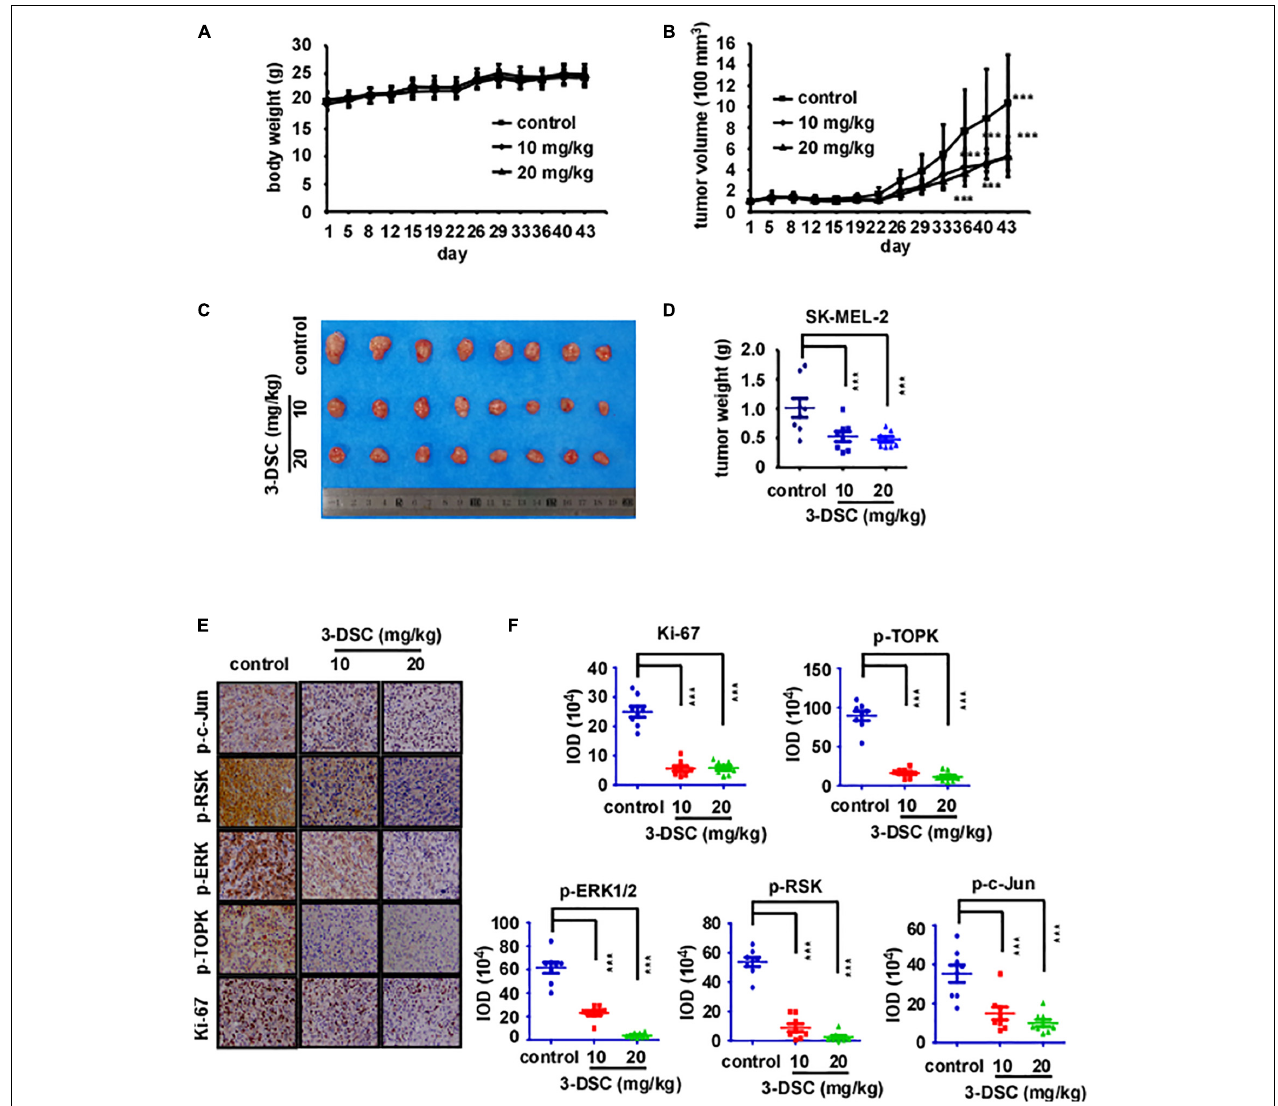
FIGURE 6 | 3-DSC inhibited skin cancer cell-derived xenograft (CDX) growth by attenuating TOPK expression. (A) Bodyweight of three groups of CDX mice over the duration of 43 days. Body weight was measured twice a week. (B) Tumor volume of three groups CDX mice over the duration of the experiment. Tumor size was measured twice a week. (C) Photograph showing tumors excised from control and 3-DSC-treated groups after euthanasia. (D) Quantification of tumor weight in panel (C) . Data are shown as mean ± SD values. (E) IHC results of CDX tumor tissues (Ki-67/p-TOPK/p-ERK/p-RSK/p-c-Jun) derived from control and 3-DSC-treated groups. (F) Quantification of IHC results shown in panel (E) . Data are shown as mean ± SD values. *** p <